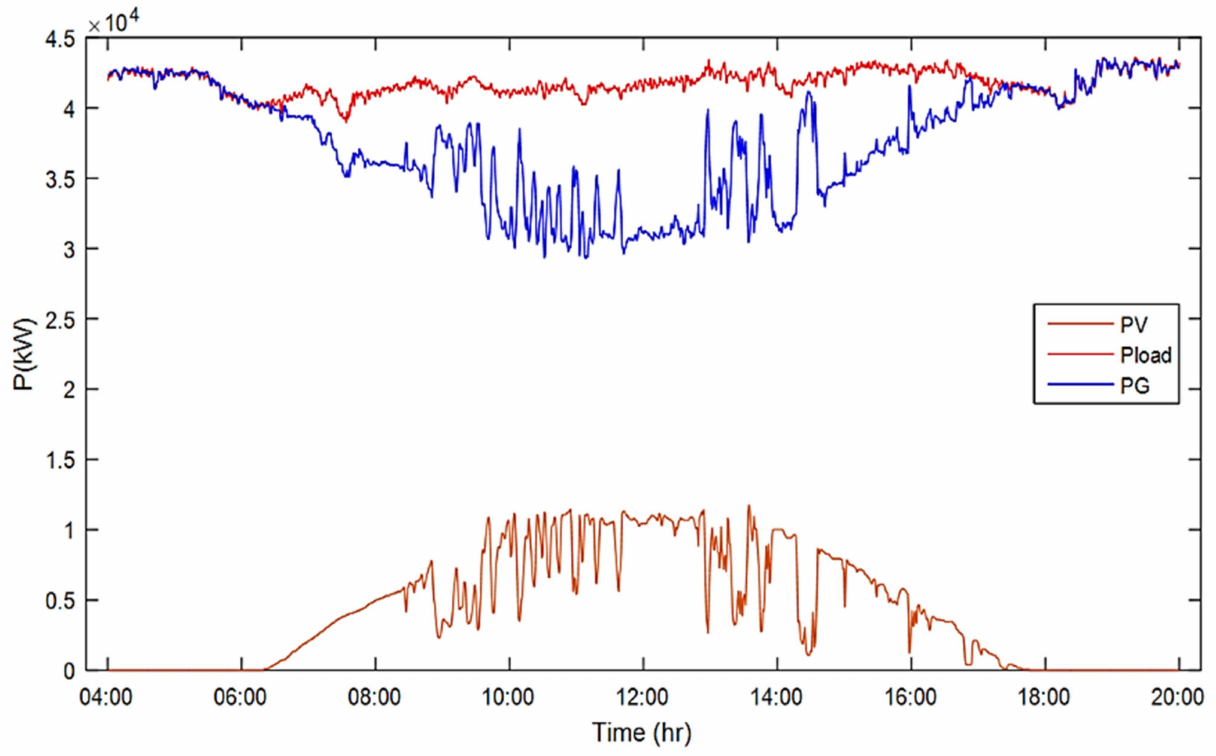
Figure 21. Observation window of the impact of solar energy (PV) and the service to be rendered (P